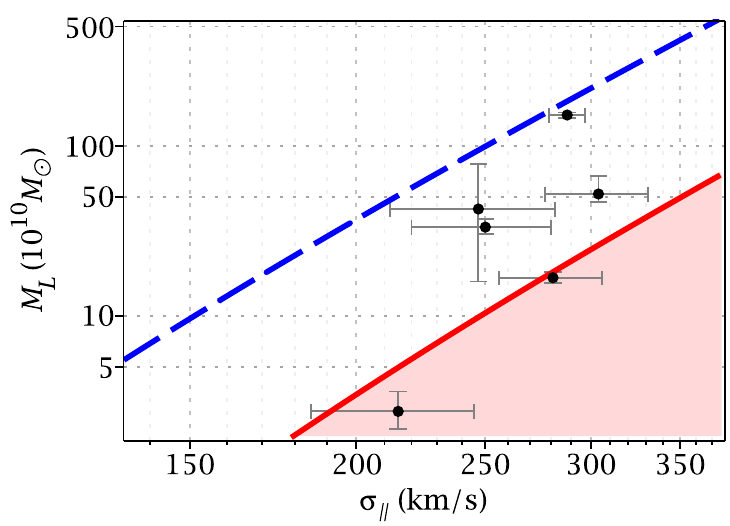
Figure 1. The relationship between lensing masses and velocity dispersions. The six data points represent the six galaxies from Table 1 for which velocity dispersion data are available. For these galaxies, the average mass-to-light ratio, computed from the lensing mass using MOG, is Υ avg = 0.77. The blue dashed line shows the Faber-Jackson relationship for this value. The lowest mass-to-light ratio in this sample of six galaxies is Υ min = 0.24. This case, calculated for an edge-on disk galaxy and indicated by the solid red line, represents a limiting case. No galaxy that is virialized and unaffected by external fields should be located in this